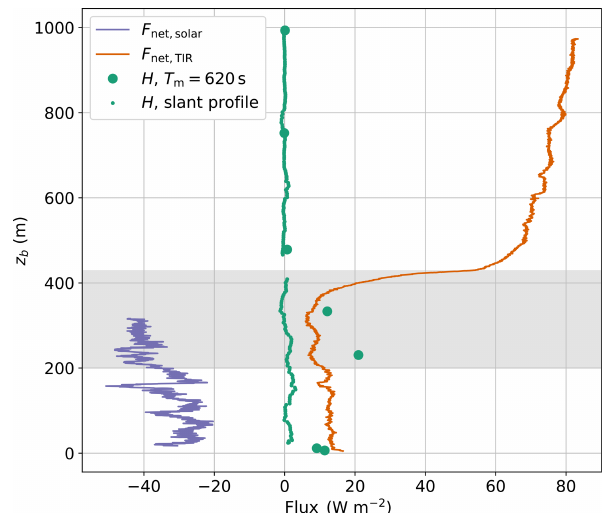
Figure 11. Vertical profile of virtual heat flux H and solar and TIR net irradiance F net on 5 June 2017. Balloon-borne virtual heat fluxes (Eq. 7) are calculated from 620s time periods at constant altitudes (big filled circles) and the slant profile with T m = 50s (dots). Posi- tive values indicate upward-oriented